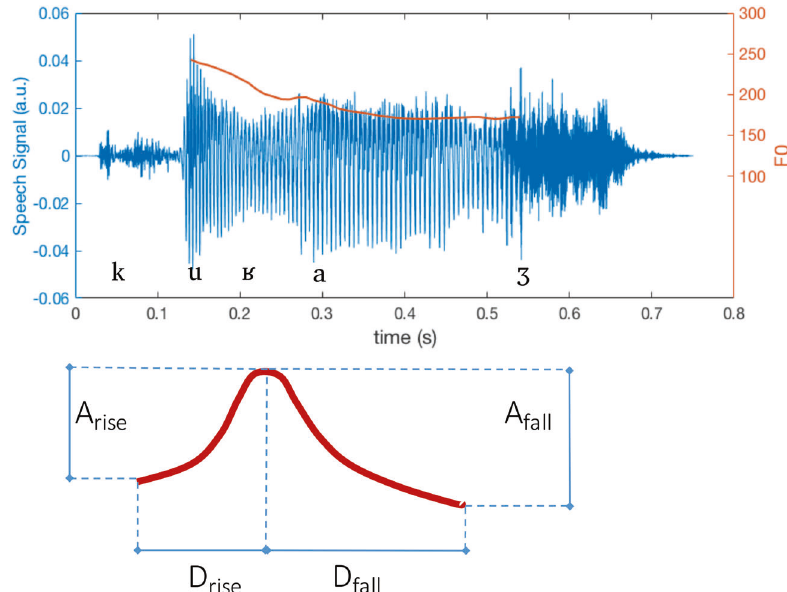
Fig. 1 F0 dynamics of the word "courage" and Taylor ’ s (2000) tilt model. Upper. The time course of audio signal related to the French word “ courage ” along with its phonetic transcription. Fricative voiceless sounds are characterized by more rapid changes with respect to voiced sound (central part of the word). For voiced sounds, the fundamental frequency (F 0 ) can be estimated and its time contour is shown in red. Lower. Taylor ’ s (2000) tilt model, whereby the falling phase is present thus resulting in geometric parameters as Duration*, and Amplitude* equal to −